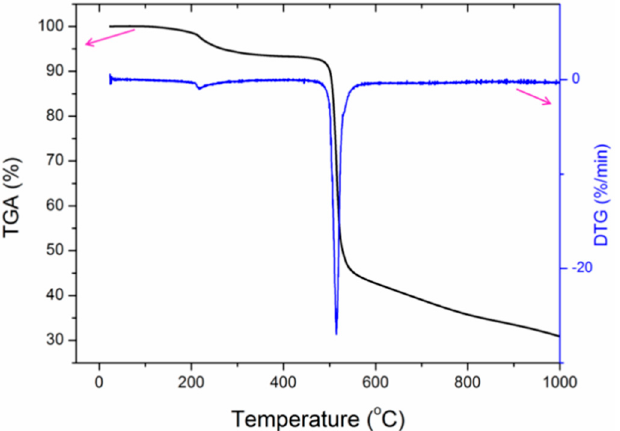
Figure 3. TGA and DTG curve for PAM.